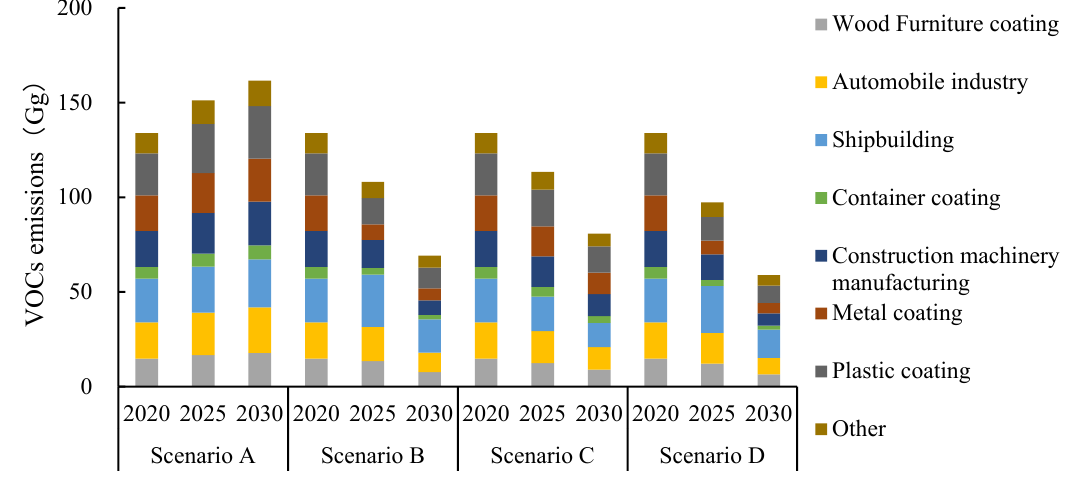
Figure 5. VOCs emissions of the surface-coating industries under different reduction scenarios from